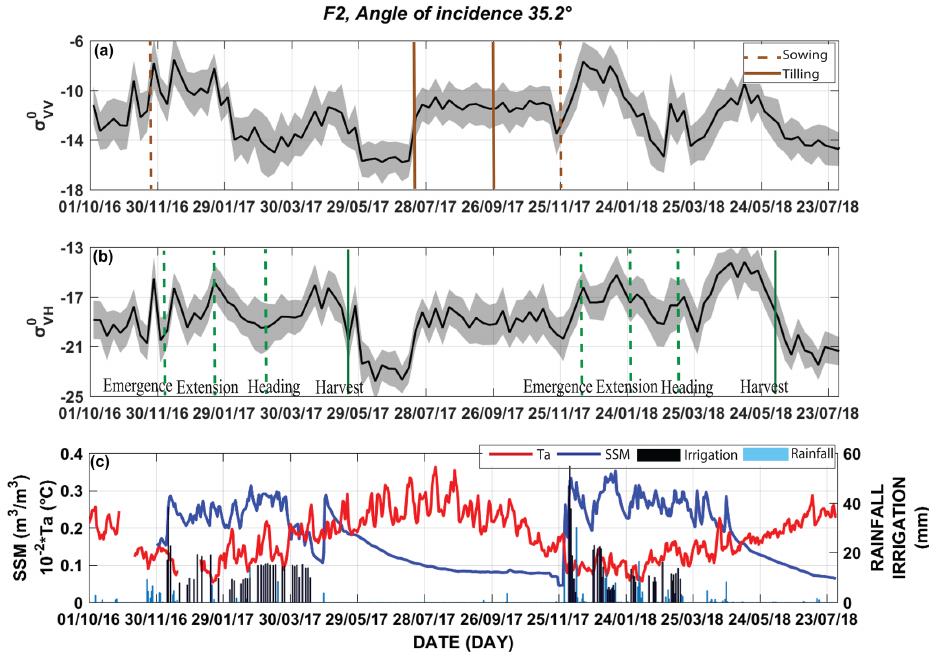
Figure A5. Time series of the backscattering coefficient at VV (a) and VH (b) polarizations on F2 at a 35.2 ◦ incidence angle during the period from 1 October 2016 to 31 July 2018. The tilling works and phenological stages of wheat are superimposed in panels (a) and (b) , respectively. The air temperature, surface soil moisture (SSM), irrigation and rainfall are displayed in panel (c) .